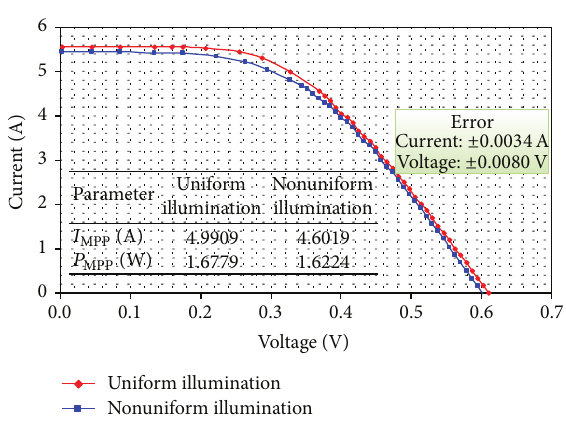
Figure 8: 𝐼 - 𝑉 characteristics for uniform and nonuniform illumi- nation of a single PV cell at medium energy concentration ratio. The peak energy flux concentration in the nonuniform illumination was